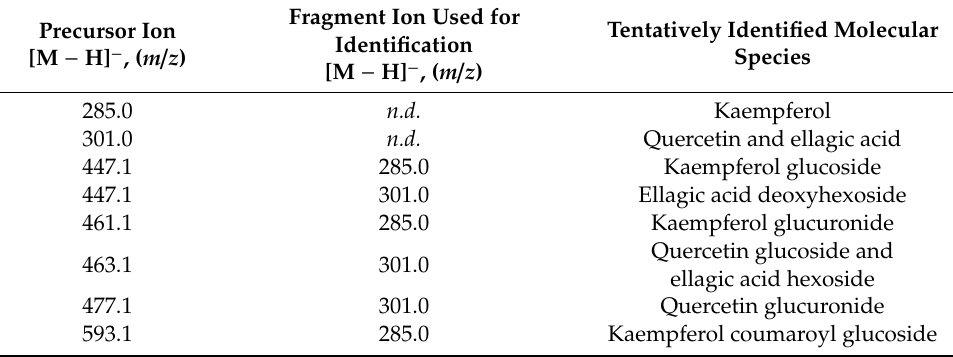
Table 2. Flavonols and ellagic acid glycosides tentatively identified in ripe strawberry fruit. Precursor